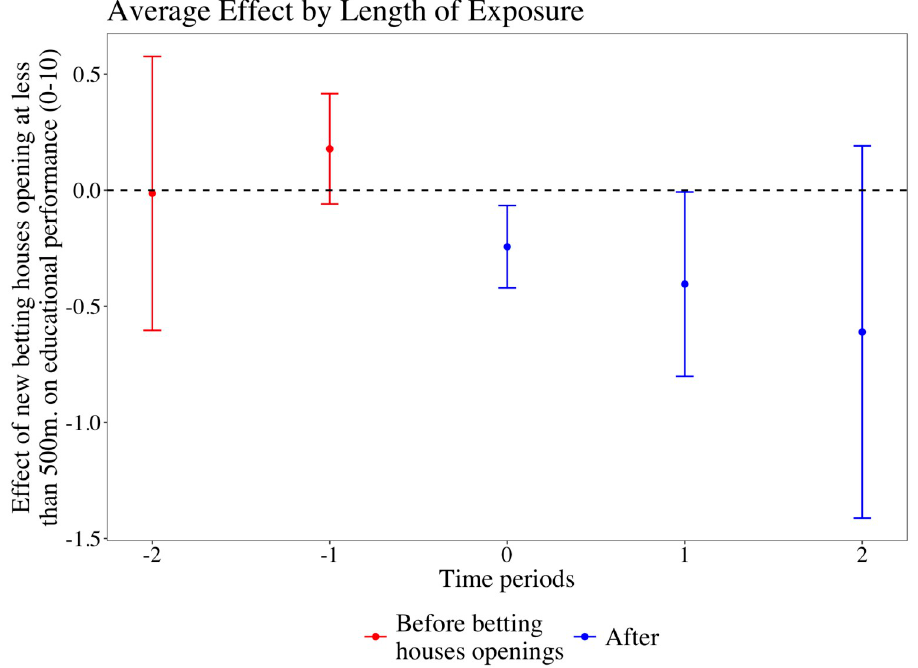
Fig 4. Estimated effect of distance betting houses on educational performance using the Callaway-Sant’Anna estimator. Note: Effect of proximity to betting houses on high school’s average mark in state-level exams. Point estimates and Confidence Intervals are obtained using a regression model that allows for effects before and after betting houses were opened.